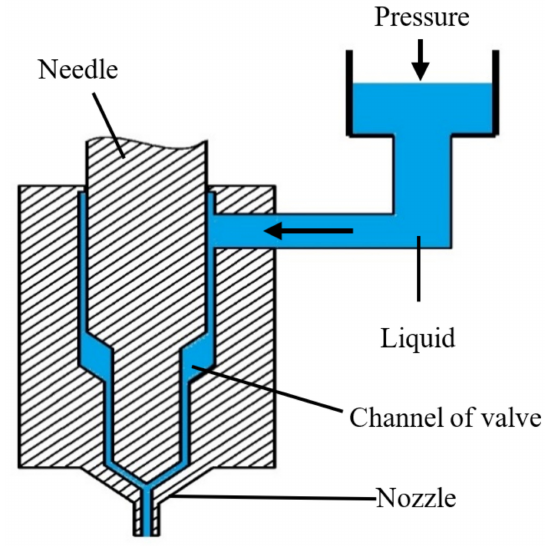
Figure 1. Principle of needle-driven type micro-injection.